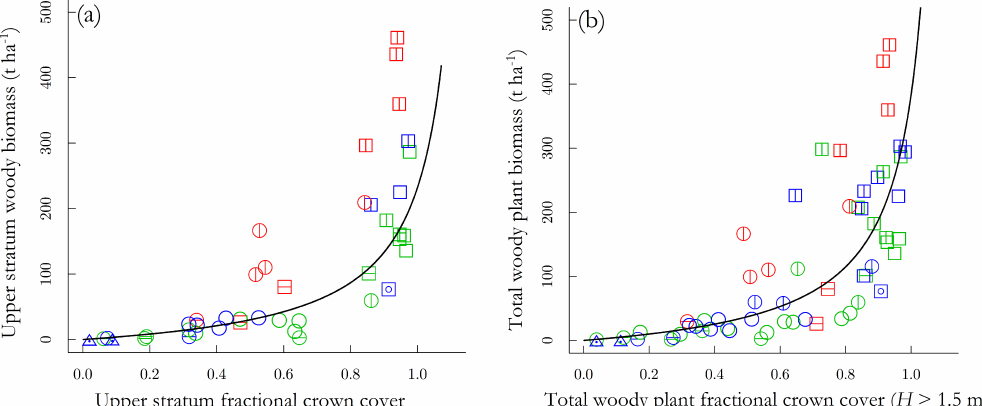
Figure 8. Relationship between (a) biomass and fractional crown cover for the upper-canopy stratum only, and (b) biomass and fractional cover for all trees and shrubs taller than 1.5m. Fitted curves represent a simple reciprocal relationship (viz. 1 /y = a + b/x ) and have been fitted using a rank based linear model regression. Symbols as in Fig. 1.